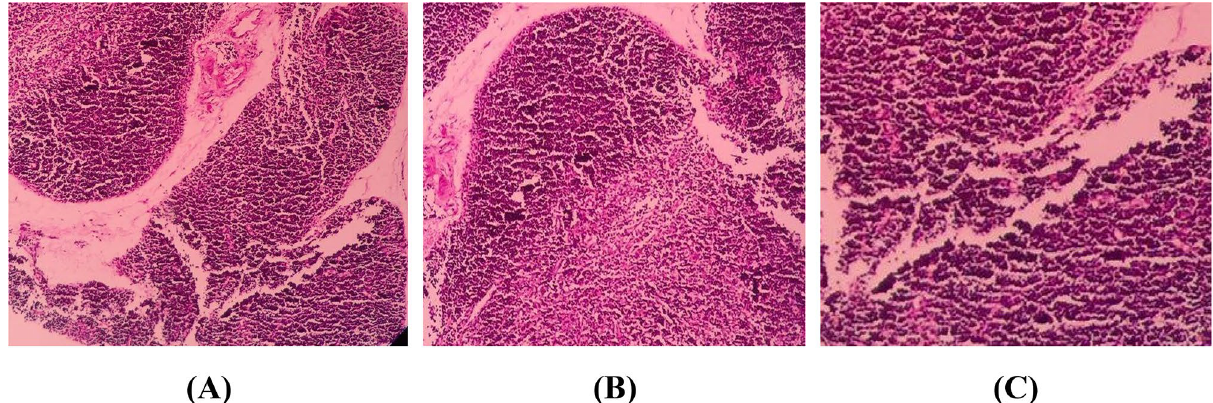
Figure 1. The histopathological effects of CH and DZN on the BALB/c thymus in studied groups. The mice thymus section in control group ( A ), DZN (20 mg/kg) group ( B ), and DZN plus CH 50 mg/kg ( C ). The pathological examination did not show any main difference in the presence or the absence of CH. The cytopathology of the cortex and medulla showed no inflammatory reactions or necrosis. Hematoxylin and Eosin (H&E) staining, × 400 magnification.